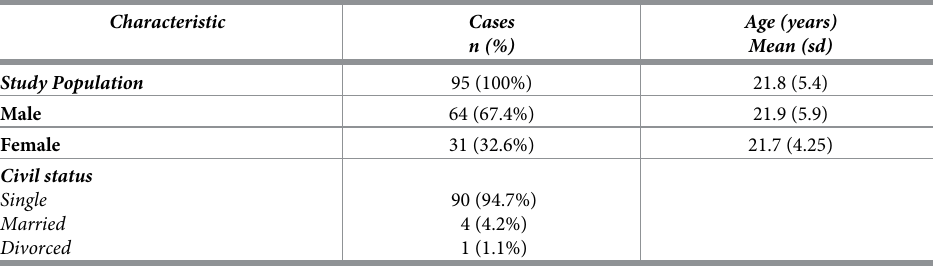
Table 1. Demographic characteristics of the study